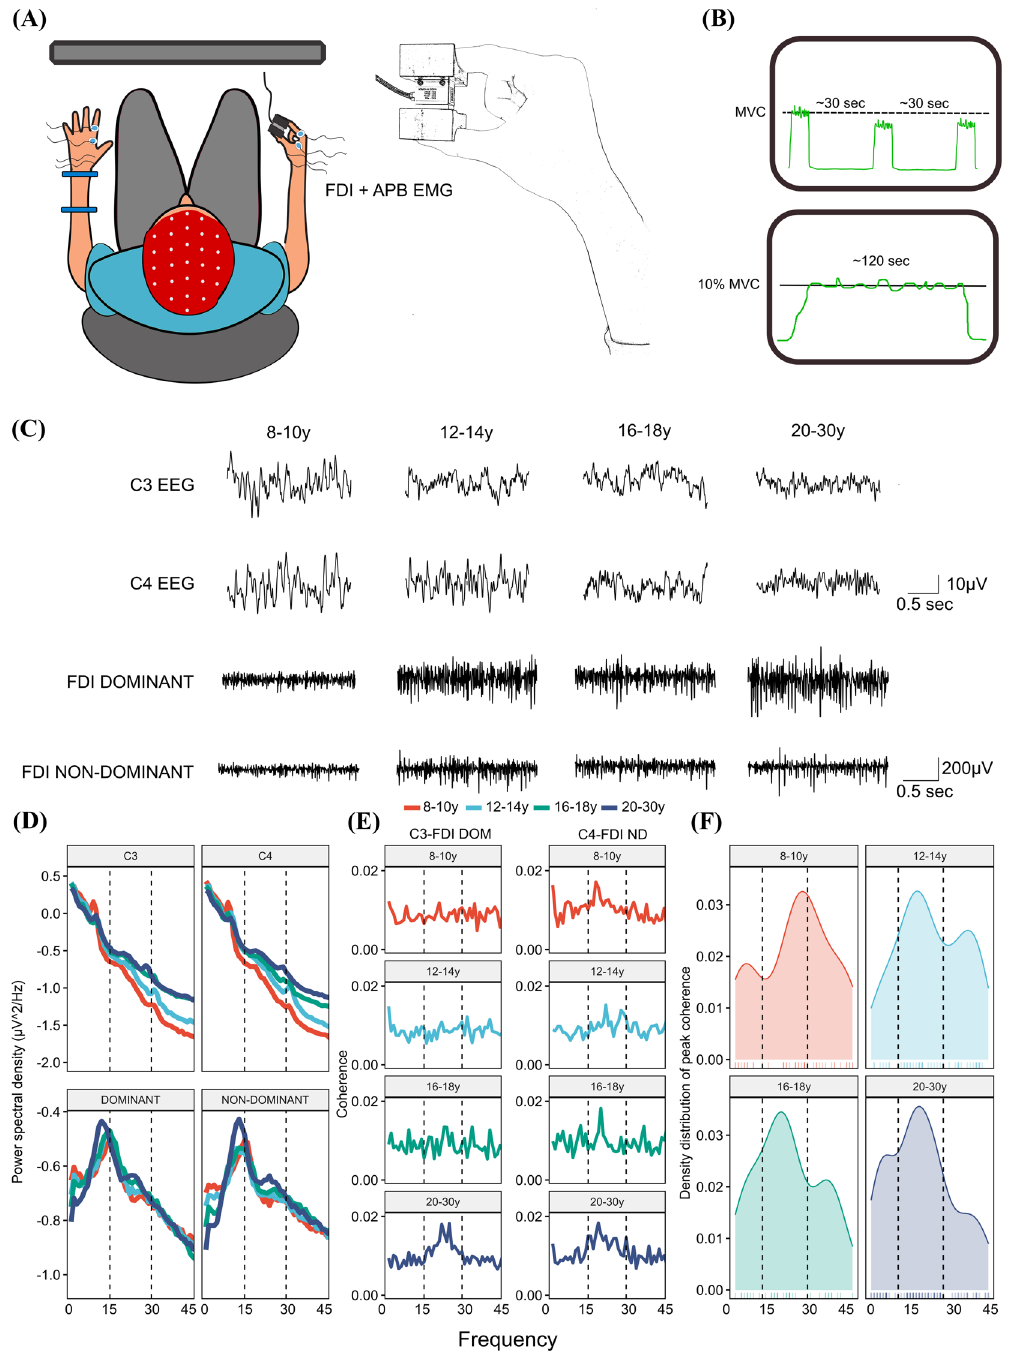
Figure 1. Experimental setup and scalp EEG and EMG data. EEG was recorded from 64-channels and EMG was obtained from the FDI and APB muscles of both the dominant and non-dominant hand. Participants initially performed three maximal voluntary contractions (MVC) on the non-dominant hand, before performing the force-tracing task in which participants were asked to maintain a steady force between the index and thumb corresponding to 10% of MVC. Visual feedback was provided as a real-time trace of the applied force ( A and B ). In ( C ) sensor EEG data and FDI EMG are presented from representative individuals from electrode C3 and C4 (located approximately above primary motor cortex) and the dominant and non-dominant hands. ( D ) Presents group-averaged sensor-level power spectral densities from the C3 and C4 EEG electrodes alongside the dominant and non-dominant FDI EMG. ( E ) Displays average coherence spectra from each of the four age groups. ( F ) Displays group-level density plots of the distribution of peak coherence frequency in the 5–45 Hz frequency range. The dashed vertical black lines in ( D – F ) mark the beta-band (15–30 Hz). Please note the common legend used for the plots in DEF. DOM = dominant hand; ND = non-dominant hand; FDI = First dorsal interosseous; APB = Abductor pollicis